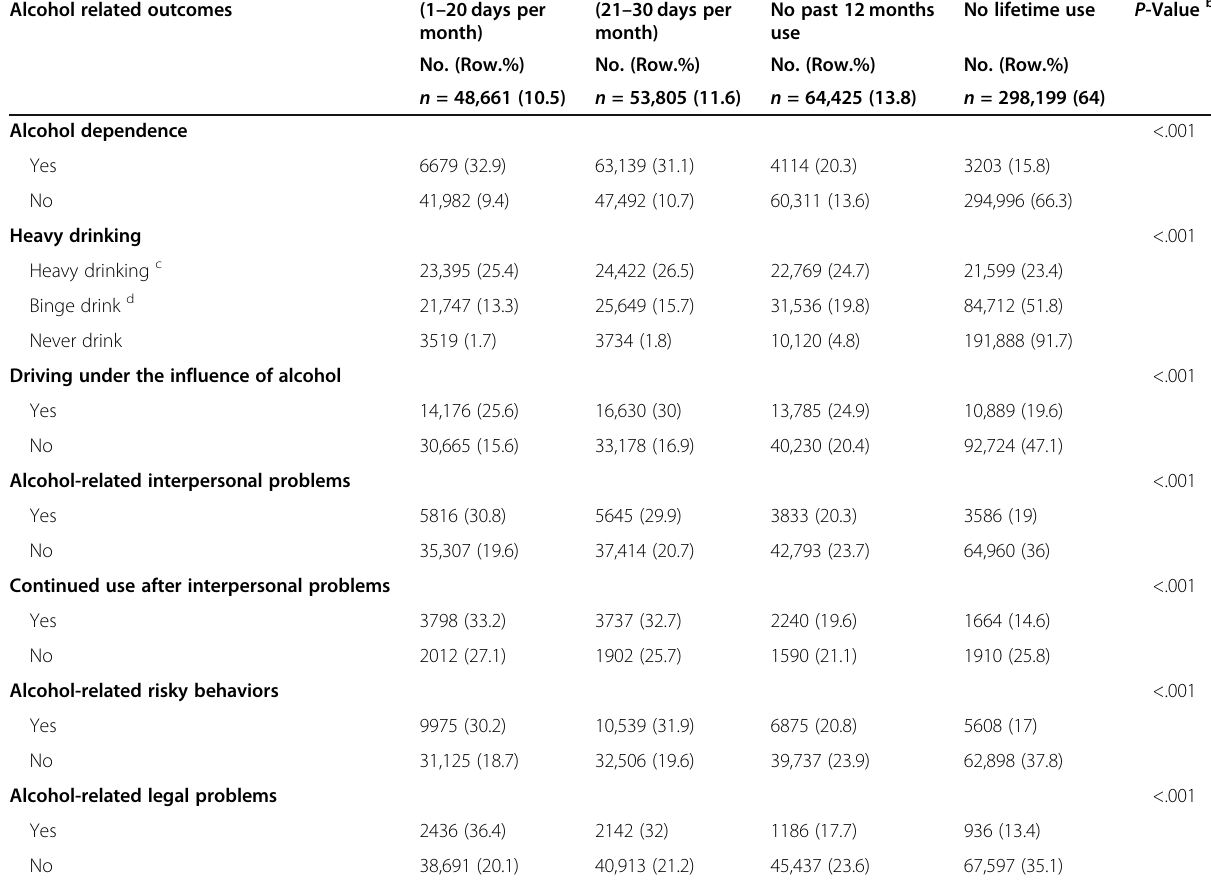
Table 2 Prevalence of past-year alcohol-associated adverse effects among past-year cannabis users a Alcohol related